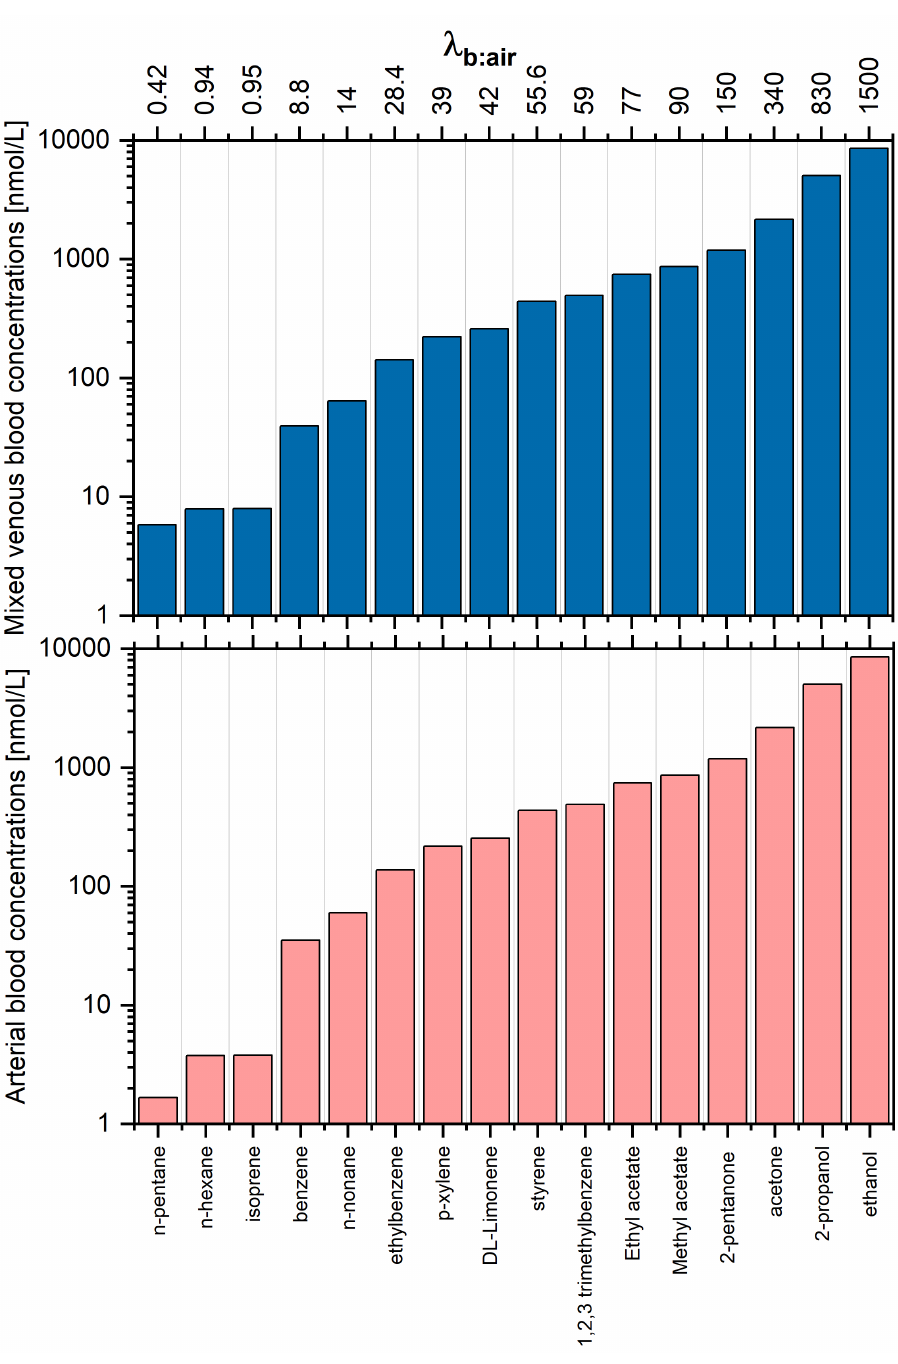
Figure 4. Estimated concentrations of VOCs under study in arterial and mixed venous blood, assuming that the end-tidal concentration is 4 nmol/L each. Compounds are ordered with respect to increasing blood:air partition coefficient λ b:air